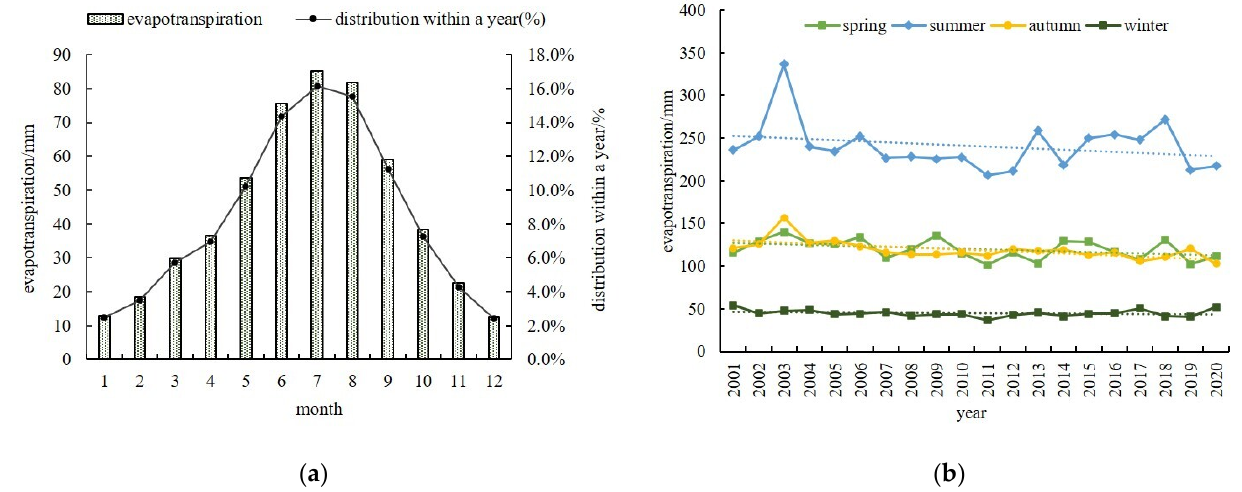
Figure 4. ETa change within a year: ( a ) monthly change; ( b ) seasonal change.